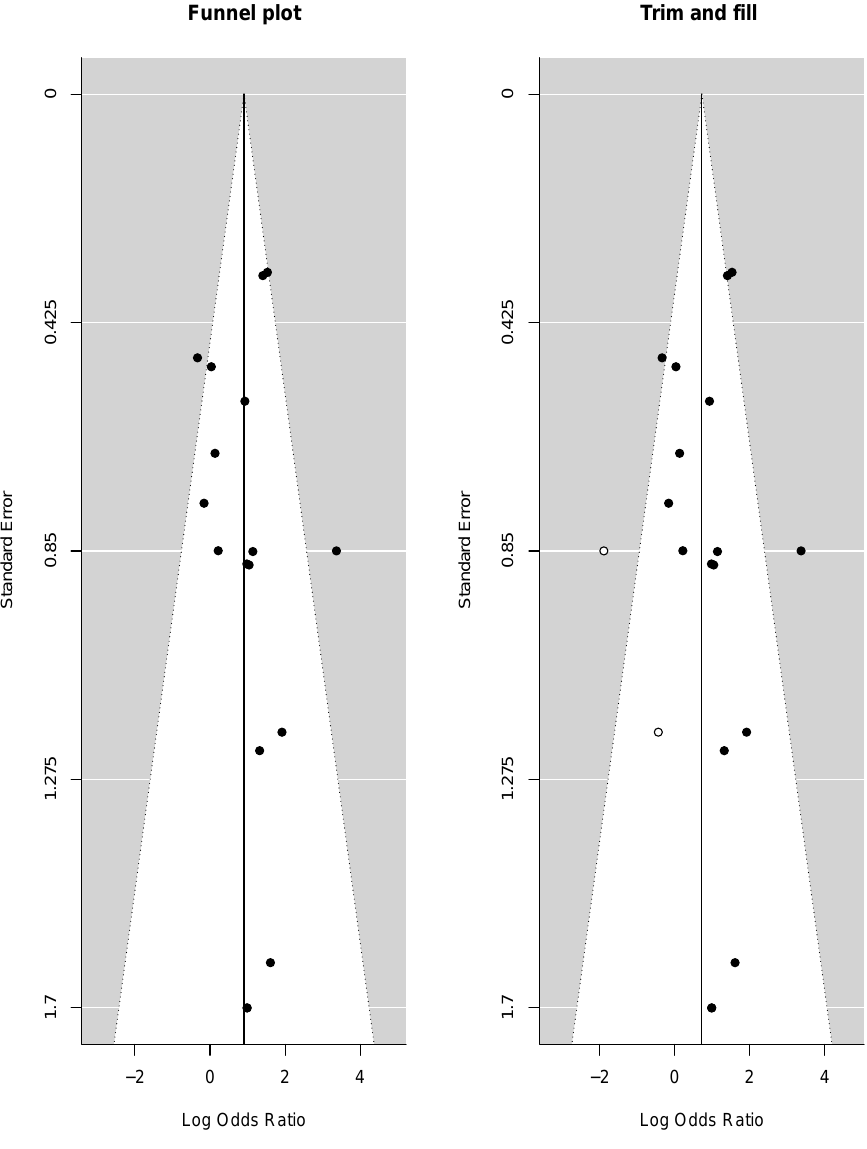
Figure 5. Funnel plot with trim and fill